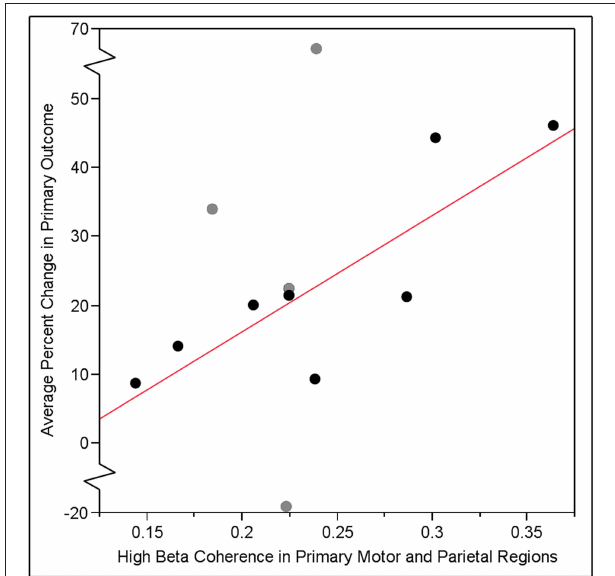
FIGURE 3 | Training-related gain in visuomotor tracking, defined as the % change in SR score, pre- vs. post-training, increased linearly as a function of baseline coherence in the high beta band (20–30Hz) between leads overlying ipsilesional primary motor cortex (iM1) and ipsilesional parietal lobe (iPAR) region identified by our group in a prior study (13) of visuomotor tracking training. The relationship between baseline EEG iM1-iPAR coherence and subsequent training-related gains was significant across all 12 subjects ( r = 0.61, p = 0.037). When analysis was repeated excluding the four subjects (gray dots) who had injury to either iM1 or iPAR, this relationship was strengthened ( r = 0.81, p =